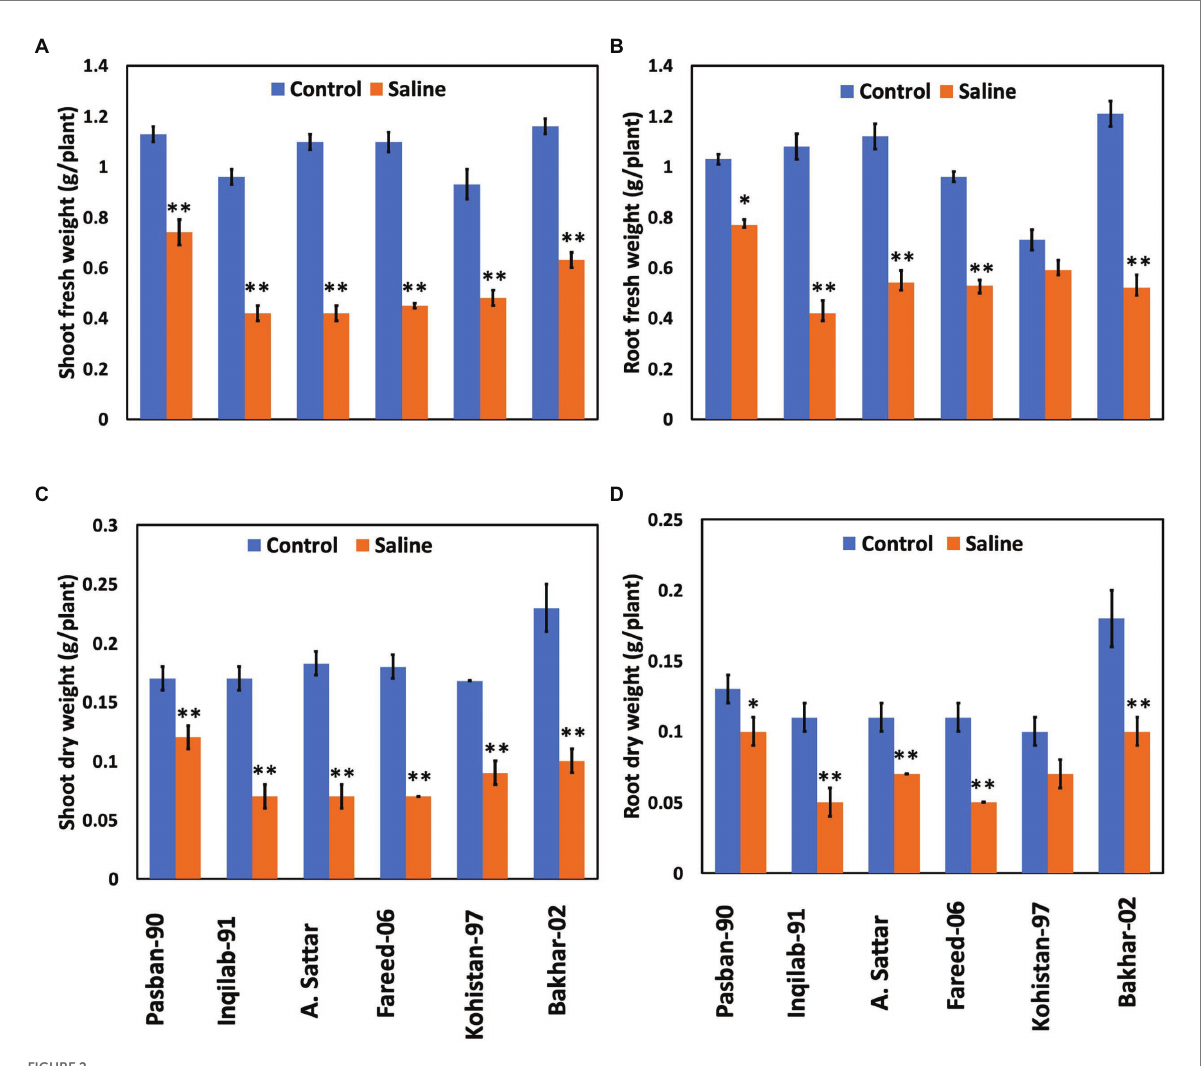
FIGURE 2 Growth attributes of wheat varieties under salt stress (150 mM) and control conditions. (A) , shoot fresh eight (B) , root fresh weight (C) , shoot dry weight, and (D) , root dry weight. Bars indicate ±. Mean values are indicated on the vertical axis. Asterisks (**) indicate that the trait mean was significantly different (value of p < 0.01) between the salt and control